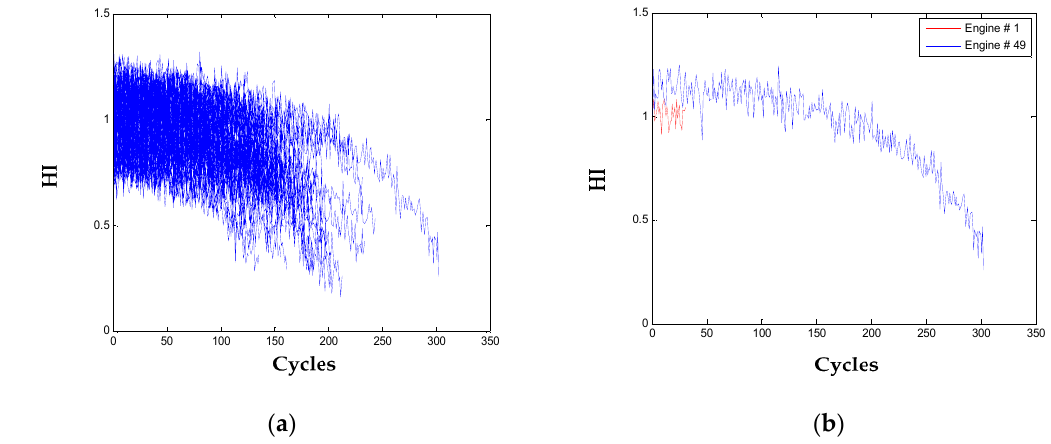
Figure 8. HI for: ( a ) all the 100 testing engines; ( b ) two engines.